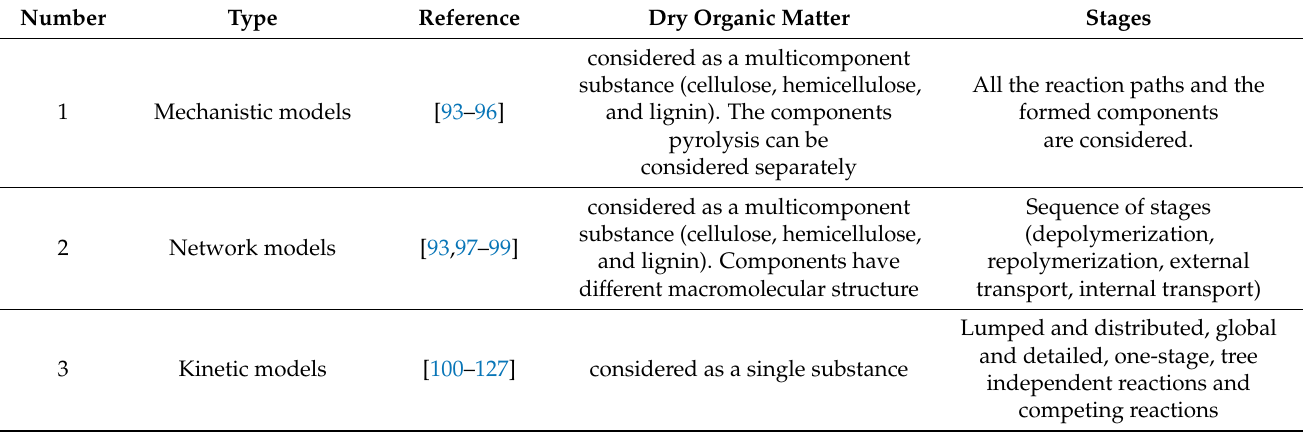
Table 2. Research on modeling of the forest fuel